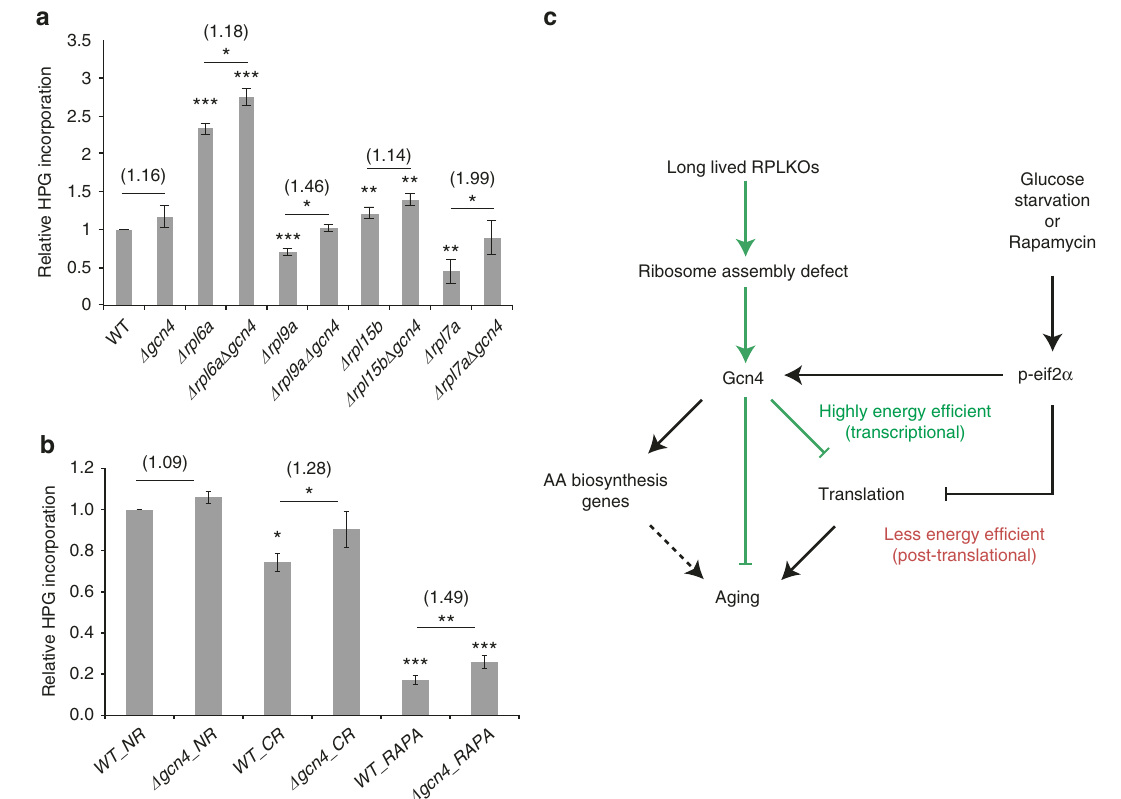
Fig. 7 Gcn4 strongly represses translation in the long-lived RPKO strains and stresses. Quanti fi cation of global translation by Click-iT HPG for a different single and double KO strains, b glucose-starved (CR) and rapamycin-treated (RAPA) yeast cells. GCN4 deletion restores translation to the level of the wild- type strain in RPKO strains and also leads to increased translation in stressed cells. The signi fi cance of the two-tailed t -test between any given deletion strain and the wild-type strain is depicted above the respective bar. Mean values of the relative translation change between the GCN4 deletion strain and the respective parental strain are shown in parentheses. Error bars represent s.d. across three different biological replicates except glucose starvation where n = 2. The p -value for the two-tailed t-test is indicated by ‘ * ’ : * p < 0.05, ** p < 0.01, *** p < 0.001. c Model for Gcn4 effect on translation and aging. Green lines indicate the fi ndings in this study, black continuous lines denote previously established links, and the dashed line indicates a connection that remains to be